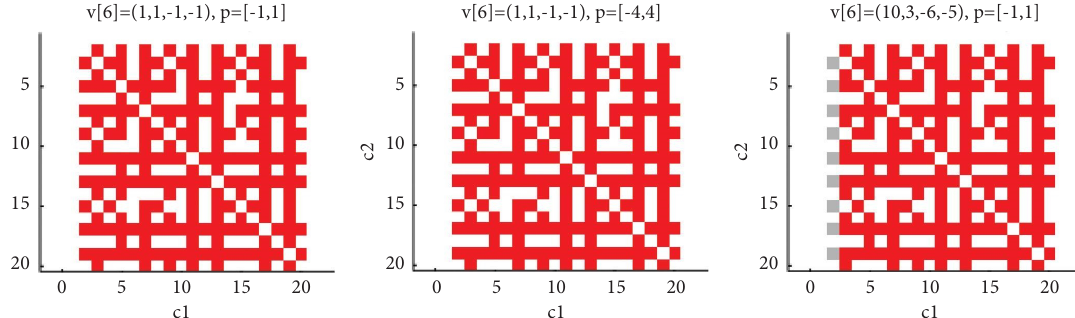
Figure 6: Attractors for tuple v harmful. In this sense, the competition exclusion principle can originate local extinction in populations. Global fxed points are those with ,c ) � 1. Notice that the fxed points for ftness tuples v gcd ( c 1 2